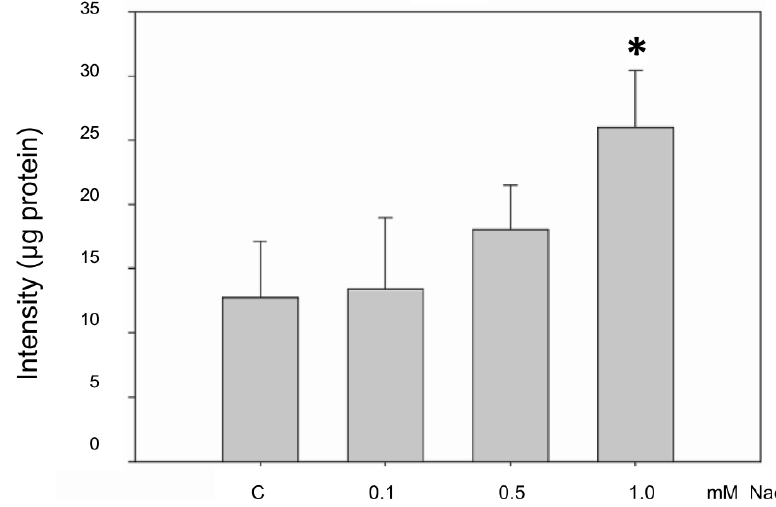
Figure 2. Glutathione (GSH) analysis of the CCD-966SK cells treated with Nac. CCD-966SK cells (1 × 10 5 cells/mL) were treated with various concentrations (0–1.0 mM) of Nac for 1 day. GSH was measured at Ex / Em 350/420 nm using fluorescence spectroscopy. The increase of absorbance at 420 nm was expressed as the mean ± SD of three independent experiments. * p < 0.01 compared with the untreated